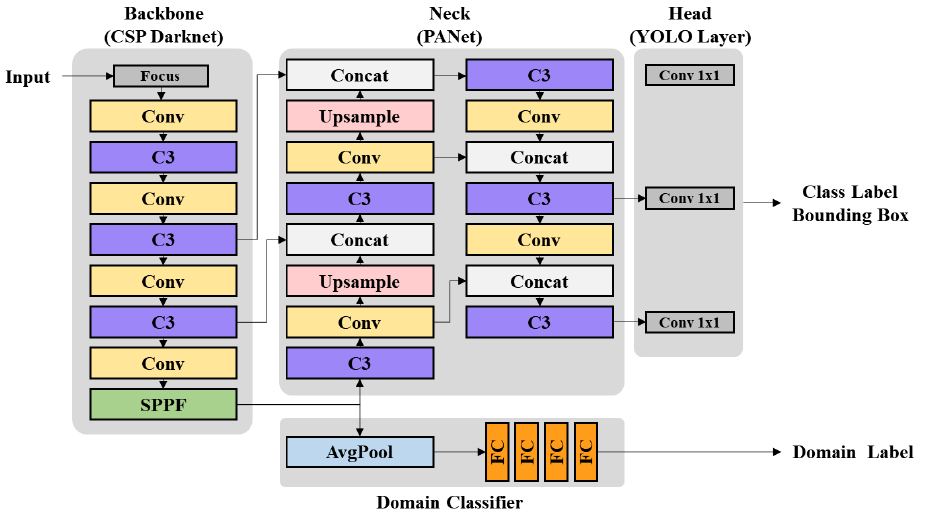
Figure 1. Overall architecture of the proposed